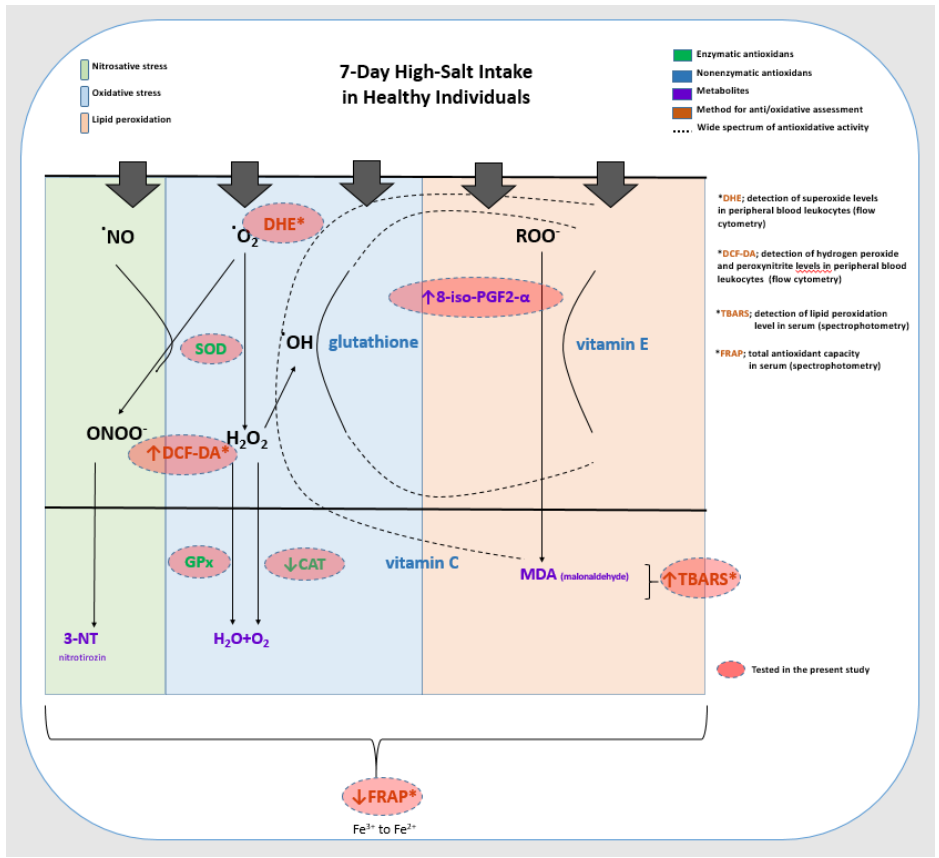
Figure 4. Summary of the effect of the 7-day high-salt (HS) diet on parameters of oxidative stress measured in the present study in young healthy individuals. This figure summarizes the most commonly known effects of the superoxide radical (O 2 •), nitric oxide radical (NO•), hydroxyl radical (OH•), and peroxyl radical (ROO•) in the formation of oxidative stress (blue), nitrosative stress (green), and lipid peroxidation (orange). The effects of enzymatic (green) and non-enzymatic (blue) components of antioxidative defense are also described, as well as the spectrum of their antioxidative activity (full arrow—the reaction they catalyze, dashed line—the spectrum of antioxidative activity). Radicals, metabolites, and enzymes that were measured in the present study as markers of oxidative stress and antioxidative defense are indicated in red filled circles. Seven days of the HS diet increased oxidative stress levels, which manifested as increased lipid peroxidation (increased serum TBARS and 8-iso-PGF2 ɑ ) and increased intracellular H 2 O 2 and ONOO- production in peripheral blood